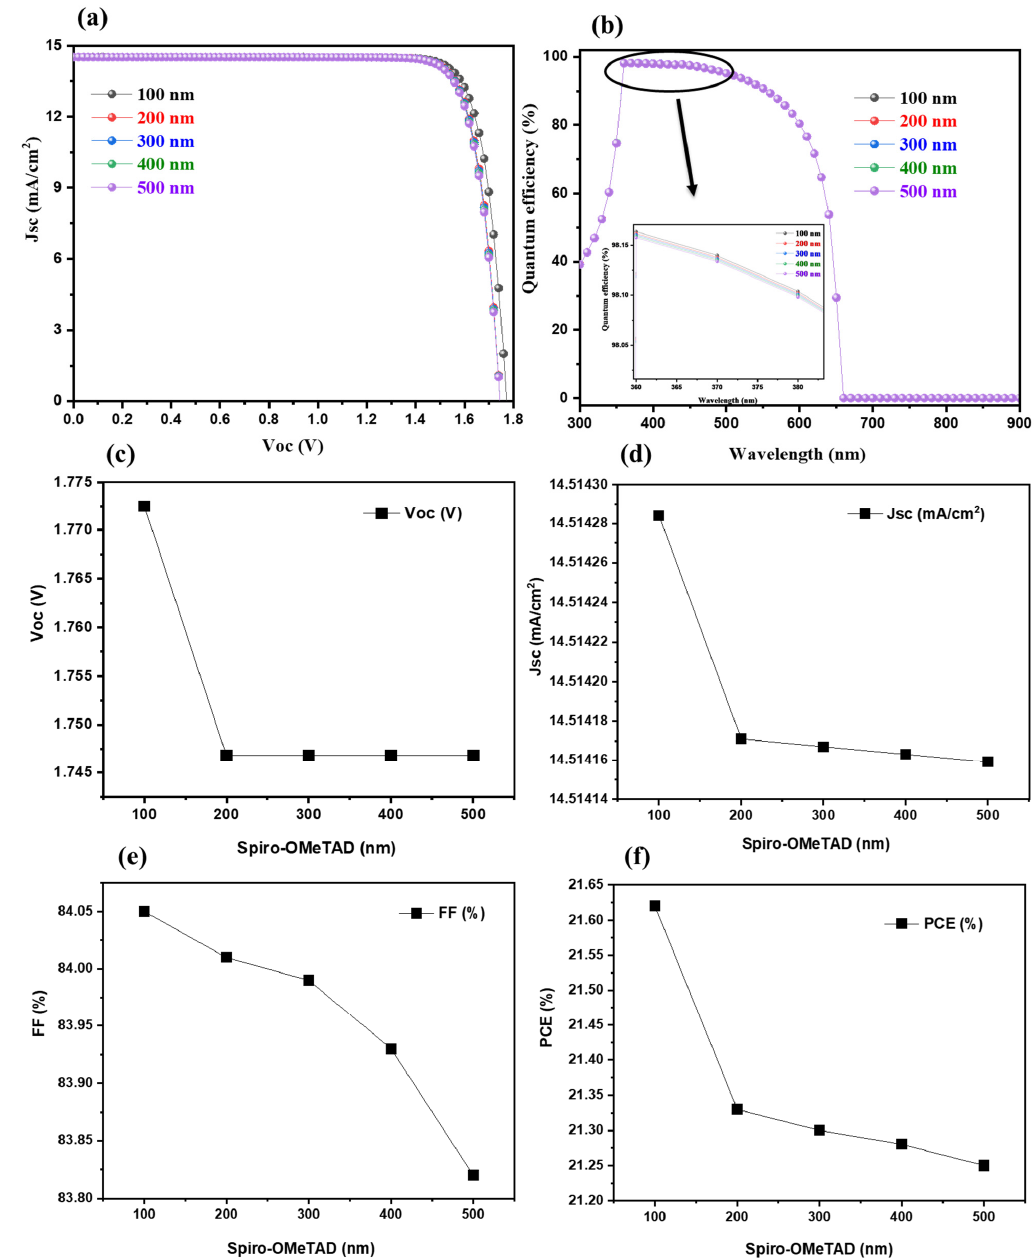
Figure 7. J-V curves ( a ), EQE curves ( b ) of the simulated PSCs (FTO(500 nm)/ZnOS(100 nm)/MAGeI 3 (550 nm)/spiro-OMeTAD(100–500 nm)) at 300 K. Inset of Figure 7b shows enlarged view of EQE curve. Extracted Voc ( c ), Jsc ( d ), FF ( e ), and PCE ( f ) of the simulated PSCs (FTO(500 nm)/ZnOS(100 nm)/MAGeI 3 (550 nm)/spiro-OMeTAD(100–500 nm)) at 300 K.